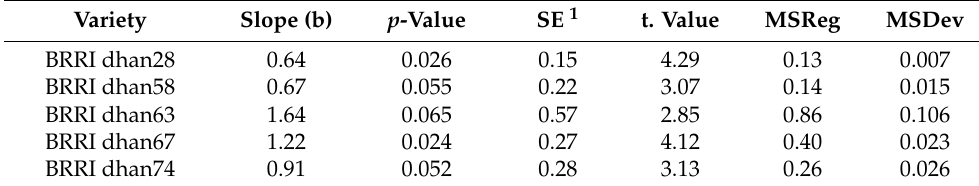
Table 5. Finlay–Wilkinson model values show the stability of rice varieties.